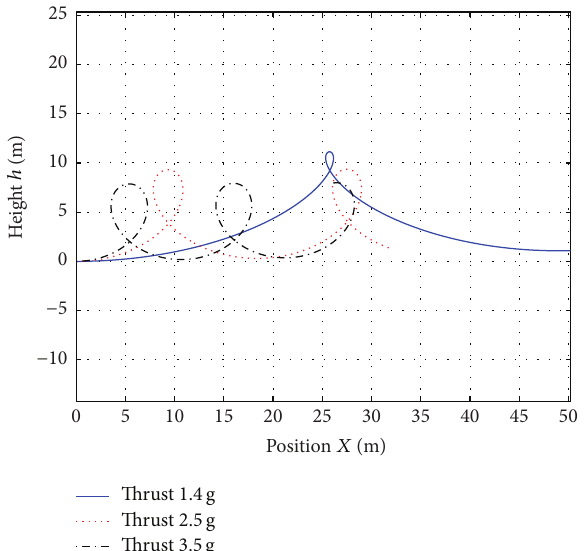
Figure 8: Varying the nomalised thrust at equal initial velocities for the period of time ( 𝑡 = 12 s).